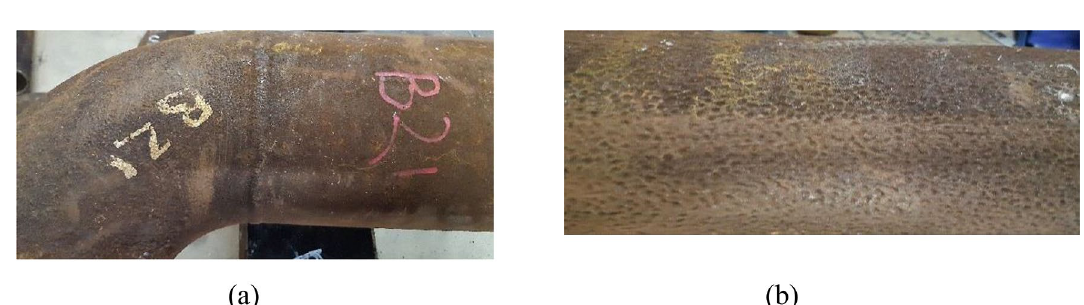
Figure 3. Images of the damaged pipe B7: ( a ) no corrosion at the hot side of the pipe facing the burner, and ( b ) slight corrosion at the cold side of the pipe facing the shell. The pipe was at the lower part of the radiant section of the heater. Slight corrosion damage occurred at the cold side of the pipe facing the shell. The damage is shallow pitting.